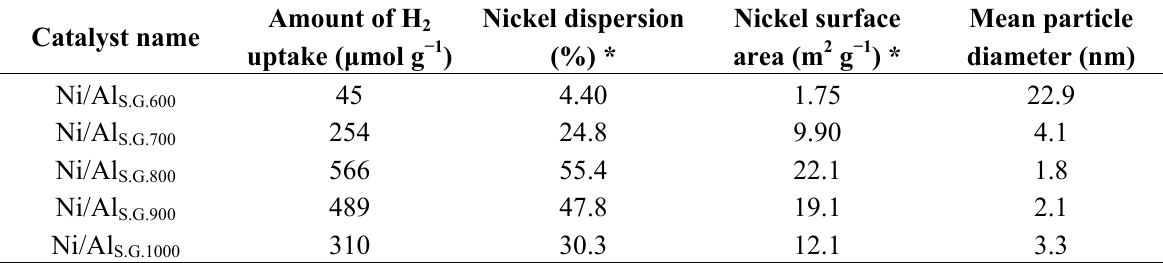
Table 2. Results for hydrogen chemisorptions